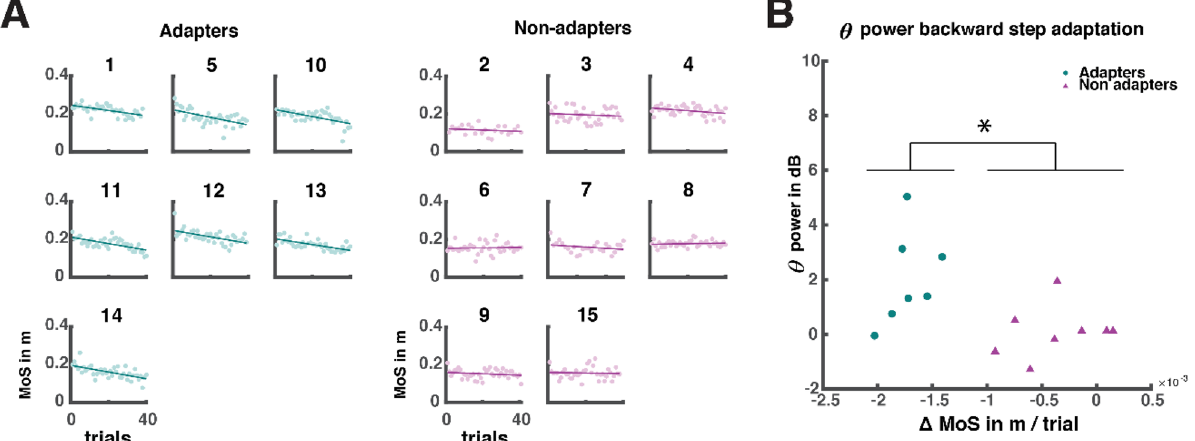
Figure 5. Adaptation of margin of stability at foot strike over the experimental time course for backward perturbations. ( A ) Participant specific margins of stability (MoS) are presented on the y-axis in meters and the trial order is presented on the x-axis. Adapters and non-adapters were classified based on significant correlations of MoS (in meters) change over trials. Numbers above plots represent the participant number. ( B ) Theta power as a function of adaptation slope in change of MoS in meters per trial. Significant difference in average theta power between adapters and non-adapters is indicated with *, p =